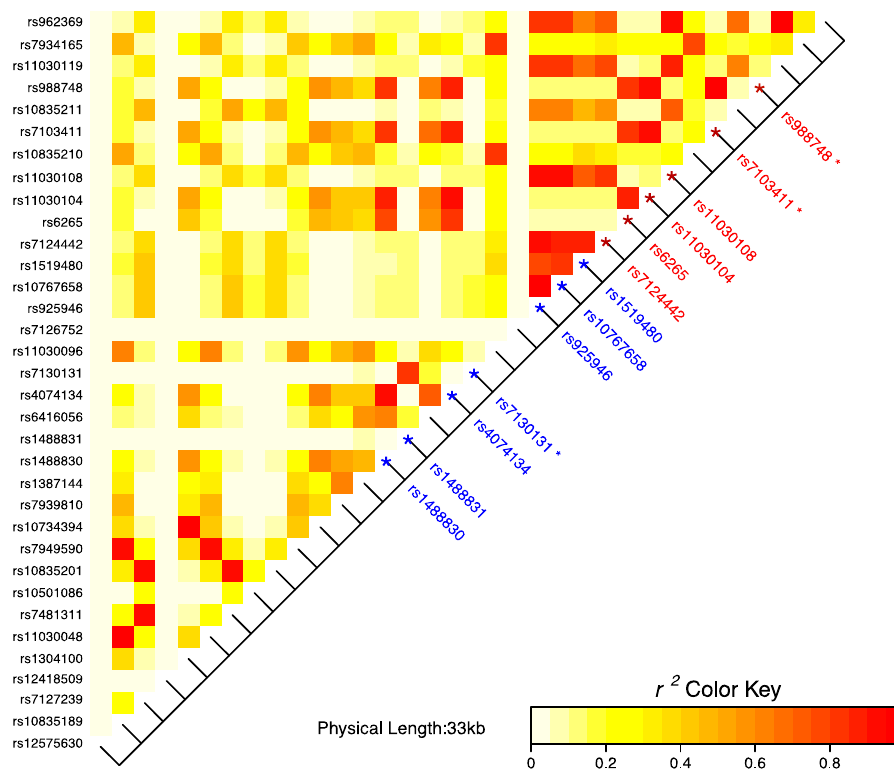
Figure 1. Linkage disequilibrium (LD) structure ( r 2 values) of BDNF and BDNF-AS markers. SNPs that are presented in the heat-map have shown significant associations with long-term visual memory. SNPs located in the BDNF and BDNF-AS genes are shown in red and blue colors, respectively. * SNPs that are significantly associated with VR II.